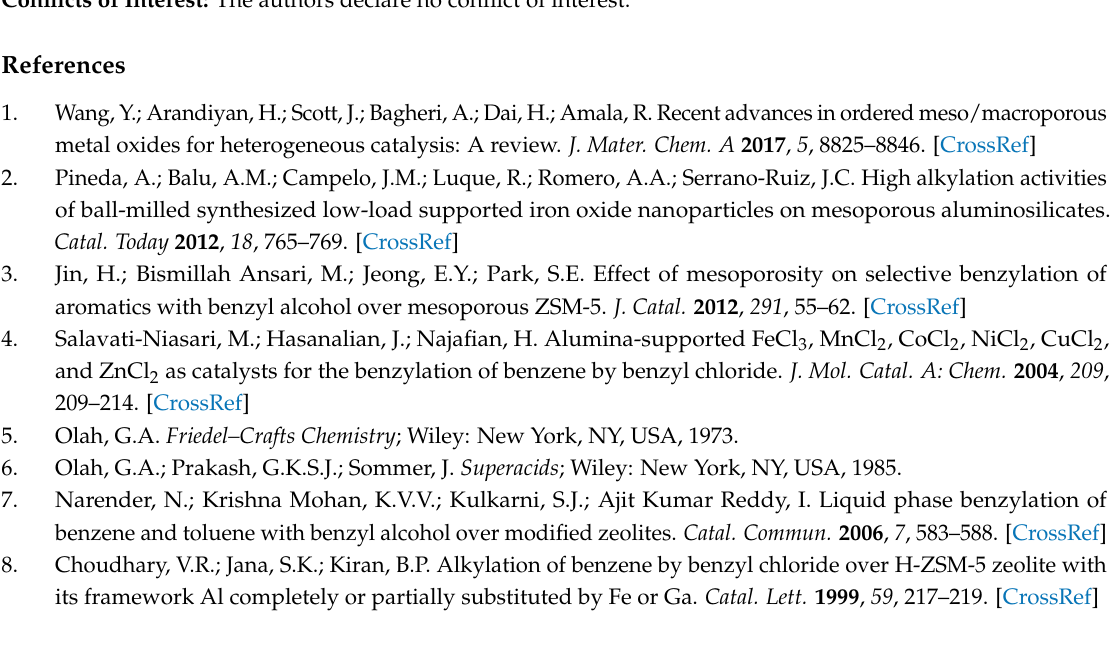
Table S1: Size of the reagent and product molecules calculated by HyperChem 5.0, Figure S1. FT-IR spectra of catalysts and Experimental